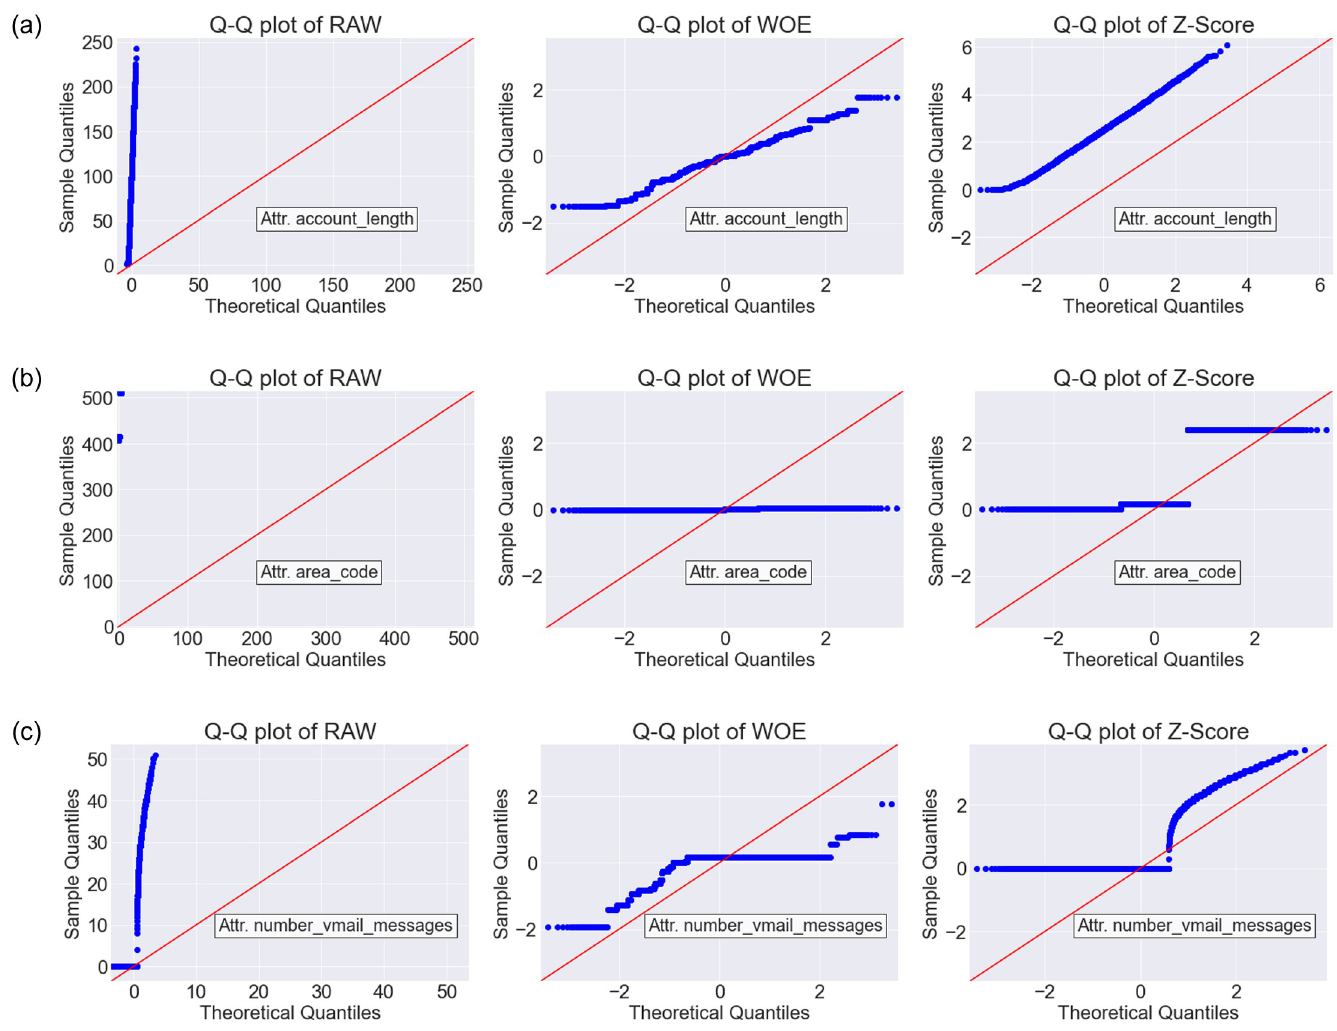
Fig 7. The Q-Q plot for RAW (without DT), WOE and Z-Score DT methods on Dataset-3.